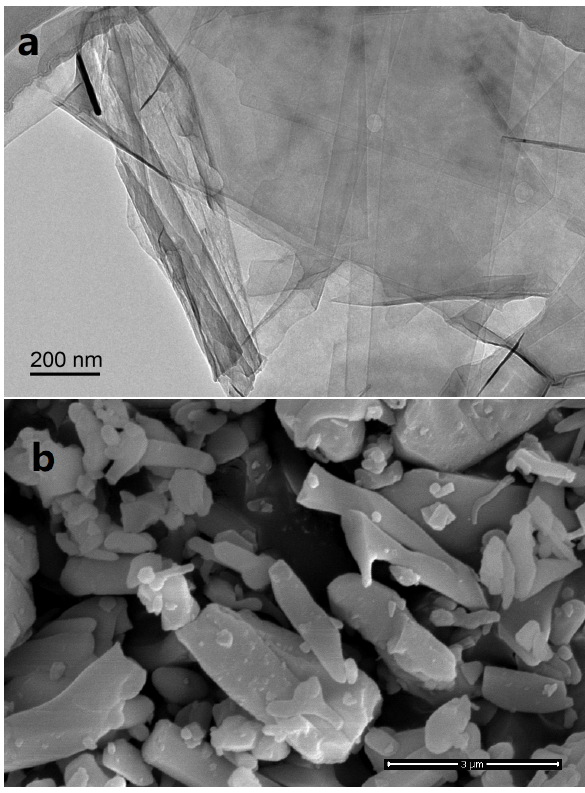
Figure 1: TEM image of NGPs and SEM image of nano-Si 3 N 4